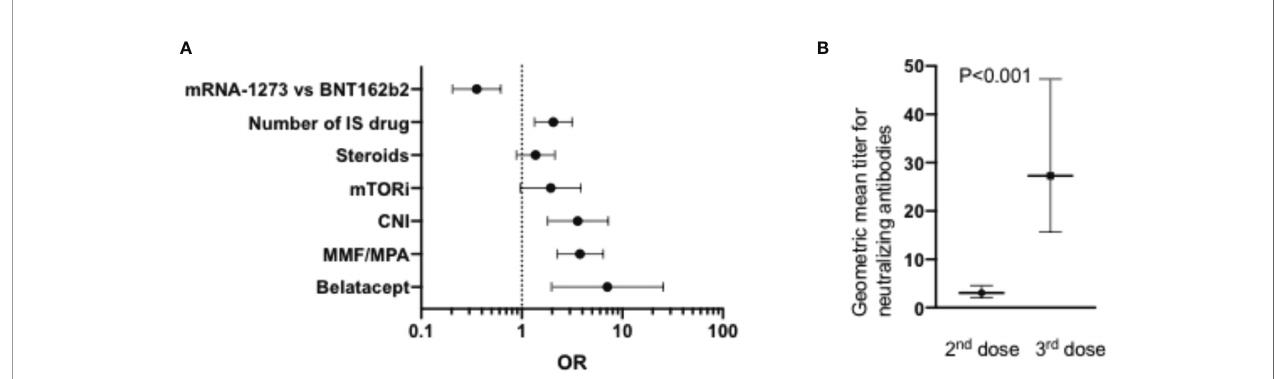
FIGURE 3 | (A) Factors associated with failure to achieve detectable Ab after two doses of SARS-CoV-2 mRNA vaccine in renal transplant patients reported by Stumpf et al. (n=368) (121). The graph shows the OR and the Wald CI from logistic regressions. (B) Impact of a 3 rd dose mRNA vaccine on neutralizing Ab titers in a cohort of 96 heart transplant patients reported by Peled et al. (122). IS, immunosuppressive; mTORi, inhibitors of the mammalian target of rapamycin; CNI, calcineurin inhibitors; MMF, mycophenolate mofetil; MPA, mycophenolic